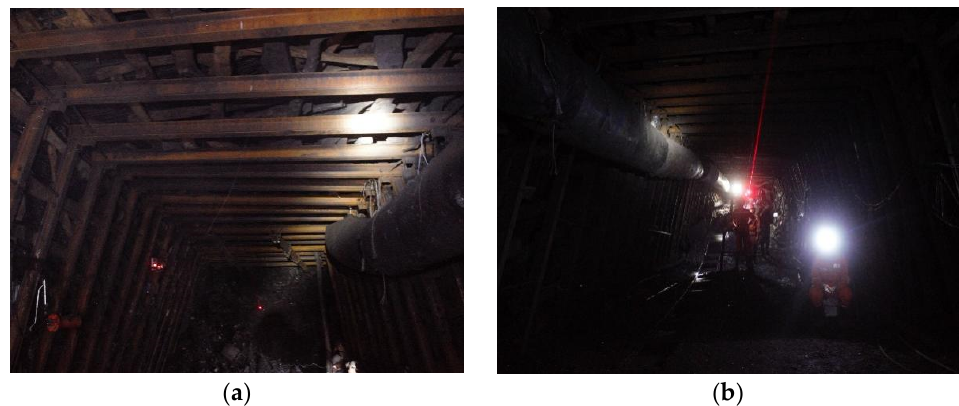
Figure 22. Support effect of return airway in working face 10905. ( a ) Return airway after support. ( b ) test section.